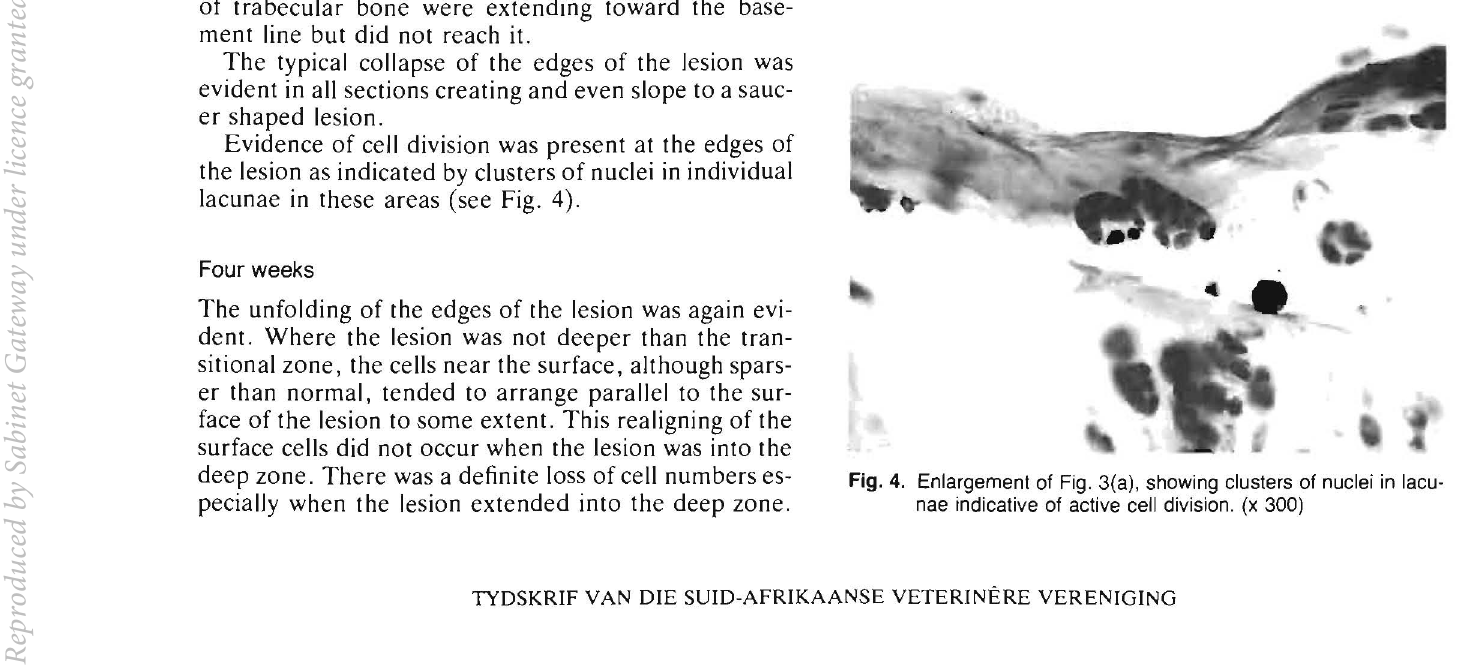
Fig. 4. Enlargement of Fig. 3(a), showing clusters of nuclei in lacu nae indicative of active cell division. (x